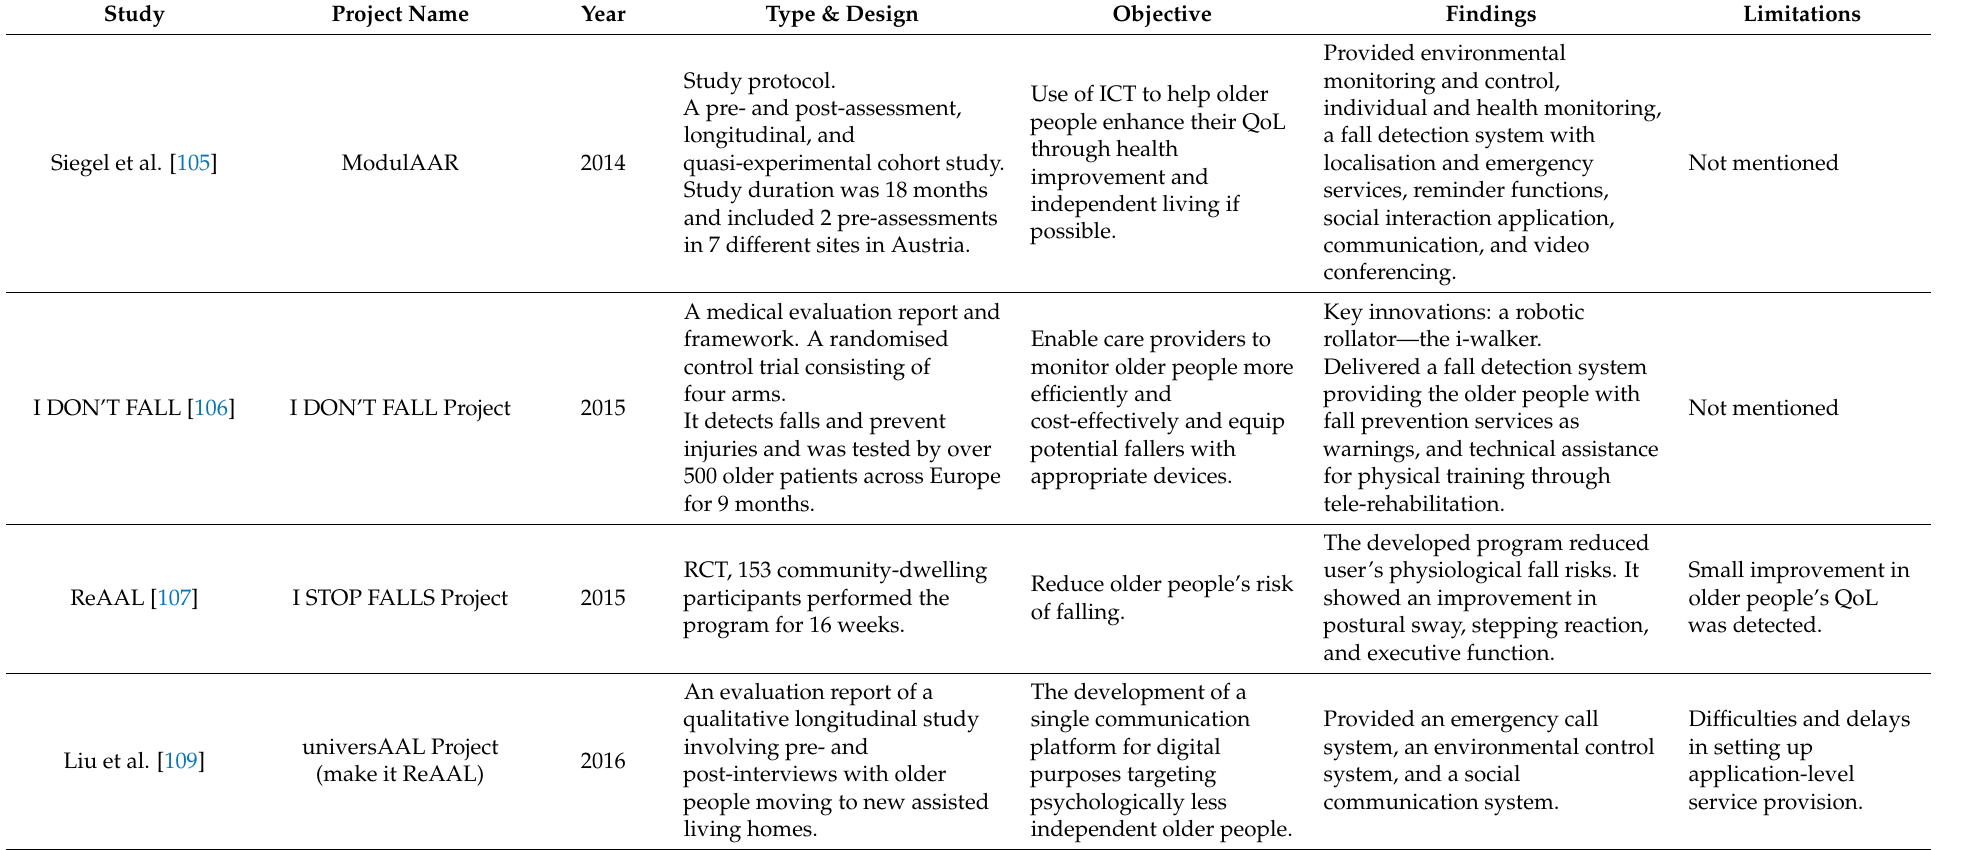
Table 9. ICT solutions for cross-fall prevention systems for assistive living of older